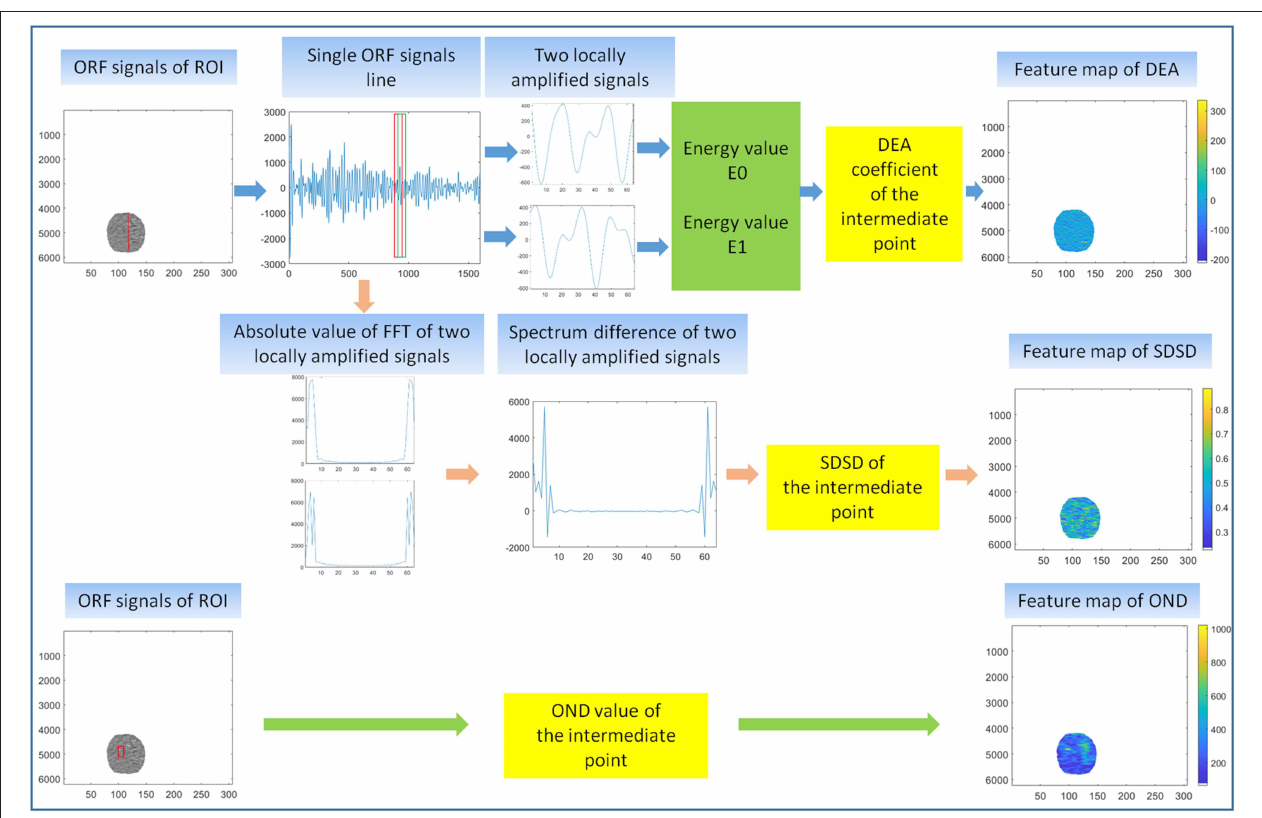
FIGURE 3 | First feature extraction. The calculation principle of original radio frequency signal (ORF) signals from region of interest (ROI) in three ultrasound feature maps, including direct energy attenuation (DEA) feature map, standard deviation of spectrum difference (SDSD) feature map, and omega of Nakagami distribution (OND) feature